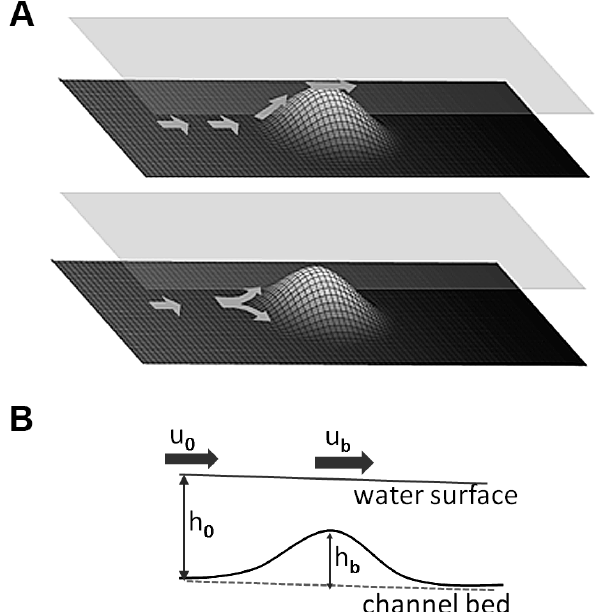
Figure 4. Setup of test 2 (flow around a mouth bar). A smooth Gaussian-shape bump is placed in a straight channel. (a) Two sce- narios are observed: (i) acceleration over the bump or, (ii) deceler- ation over the bump and diversion around the bump. (b) Sketch of the key variables: normal flow depth ( h 0 ) and velocity ( u 0 ), bump top velocity ( u b ), and bump height ( h b